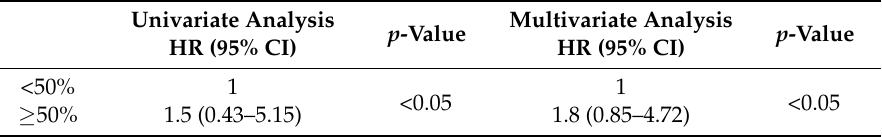
Table 2. Univariate and multivariate analysis for aquaporin-1 (AQP1) expression.